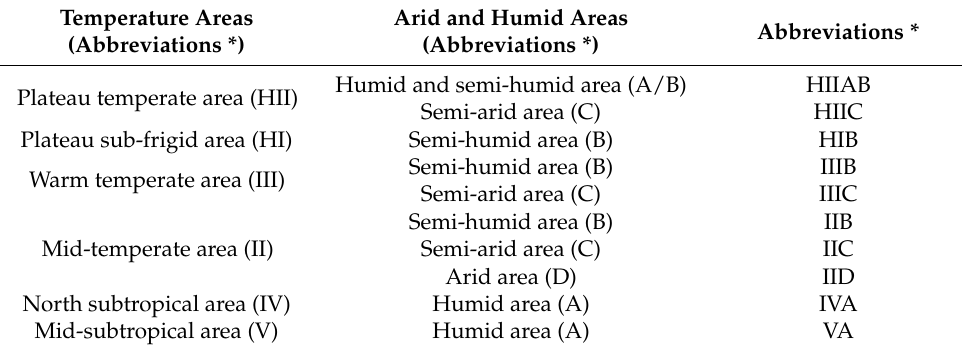
Table 1. Eco-geographical regional systems in the agro-pasture